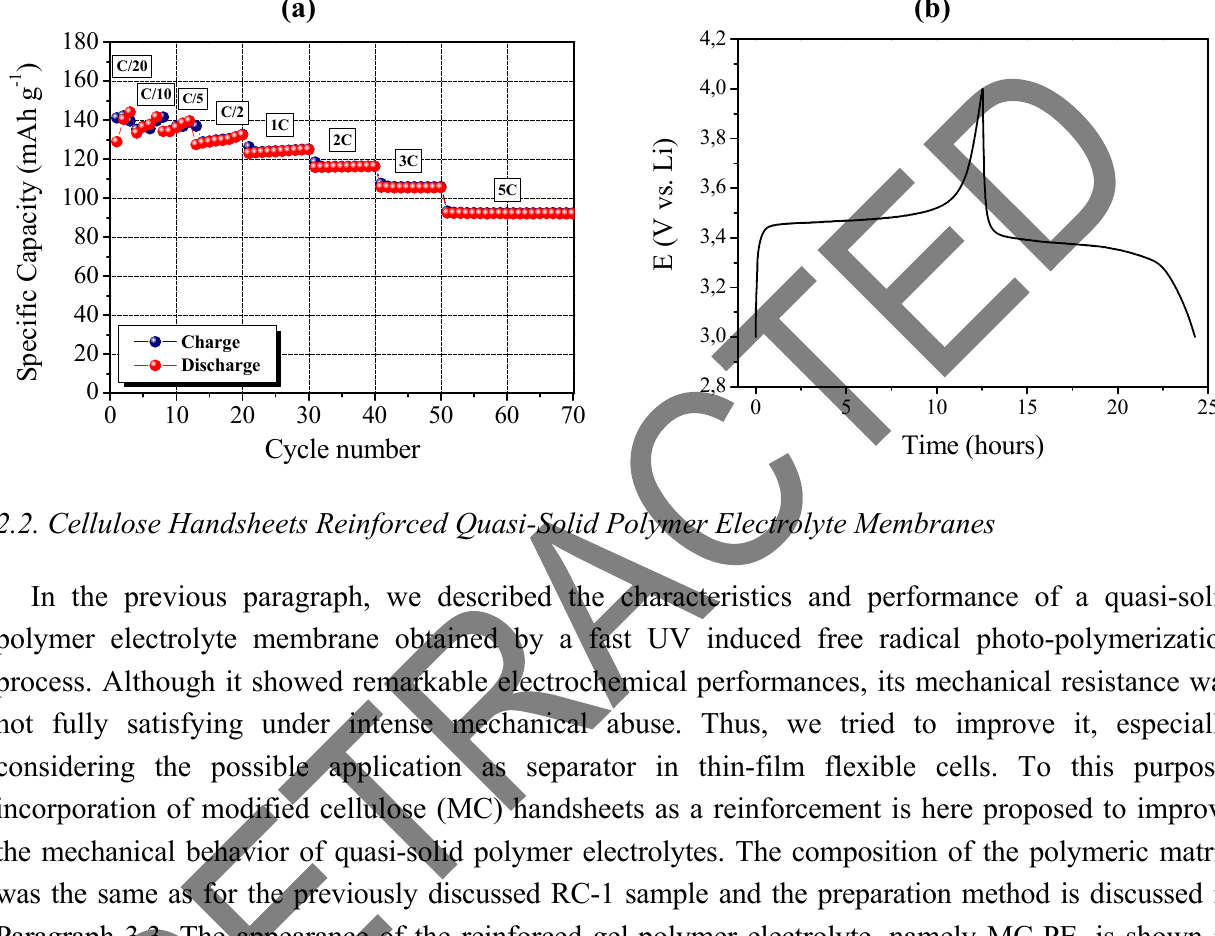
Figure 1b: it was a highly translucent, freestanding, extremely flexible and non-sticky